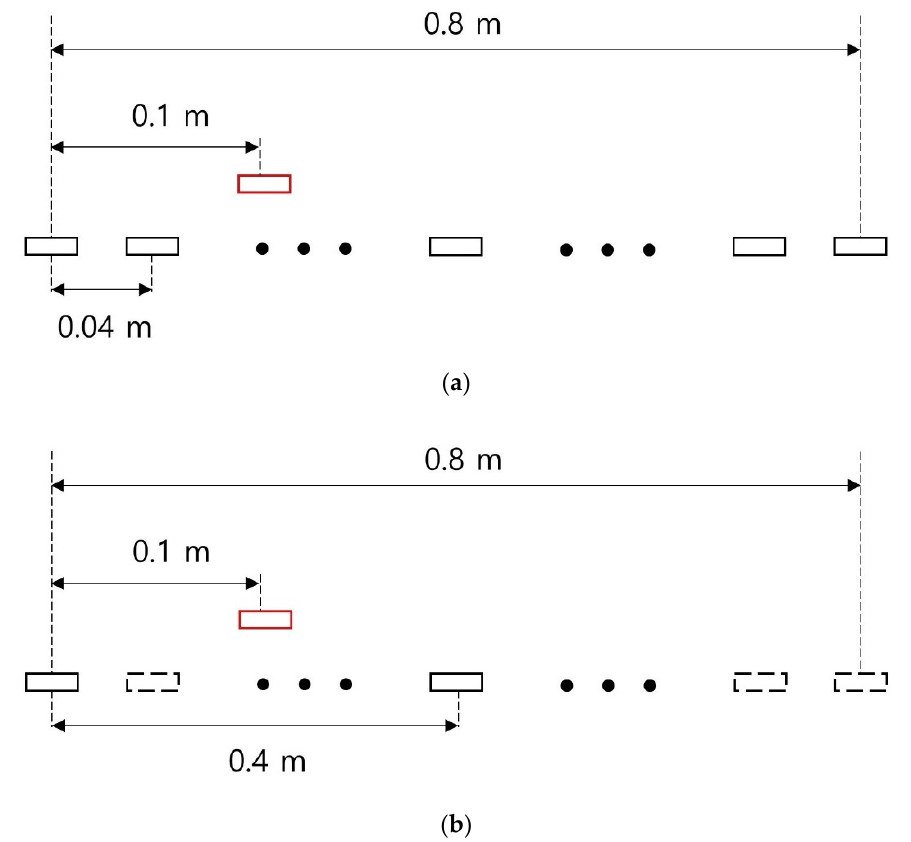
Figure 10. Description of line array in: ( a ) the first case of simulation; ( b ) the second case of simulation; the red box is a transmitter, and the black boxes are receivers. The black-dash boxes in ( b ) are actually empty but marked for comparison with ( a ).